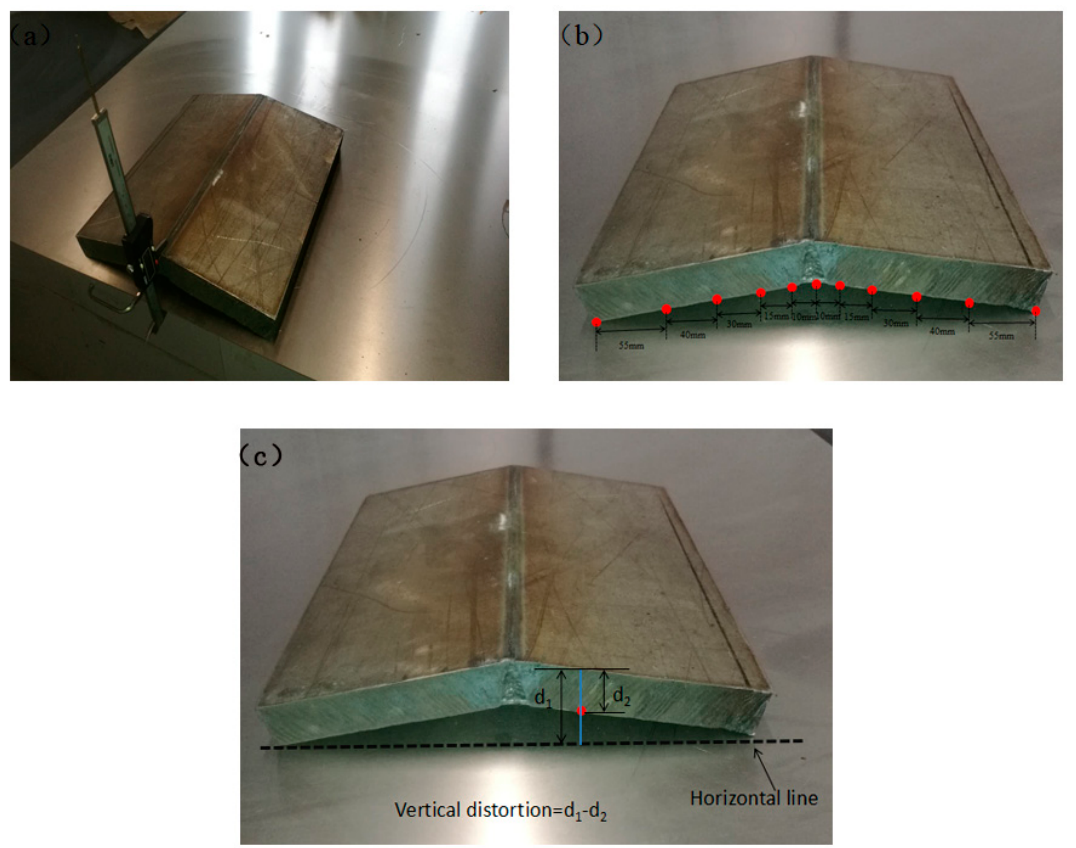
Figure 5. ( a ) The apparatus of measuring the actual distortion; ( b ) 11 positions (marked as red points) for distortions measurement; ( c ) the detailed measurement method of vertical distortions.